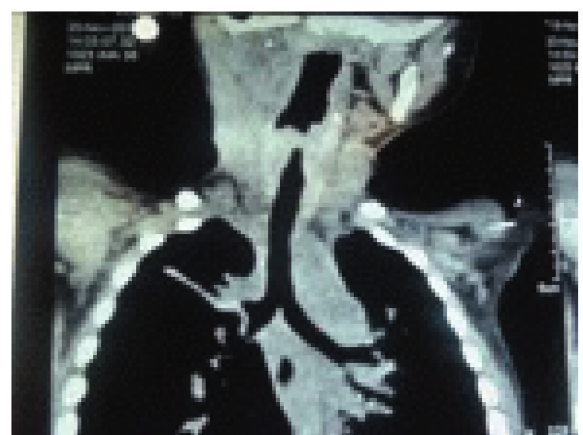
Figure 3: Postoperarative appearance on coronal CT images, after surgery for acquired subglottic stenosis; note the adequacy of the